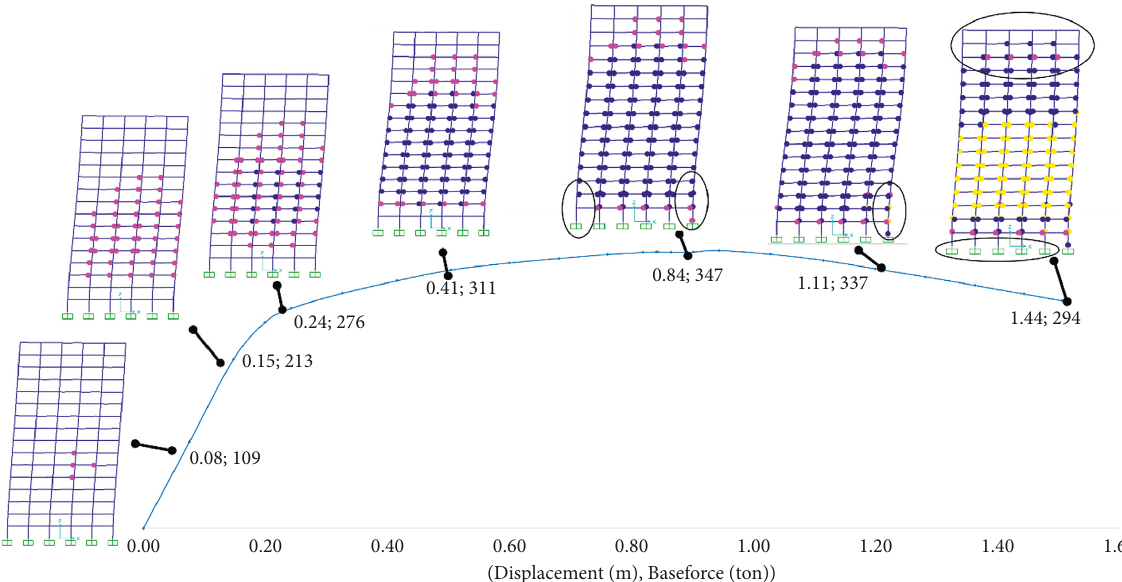
Figure 17: Push diagram of the 16-story frame designed by the LRFD method.